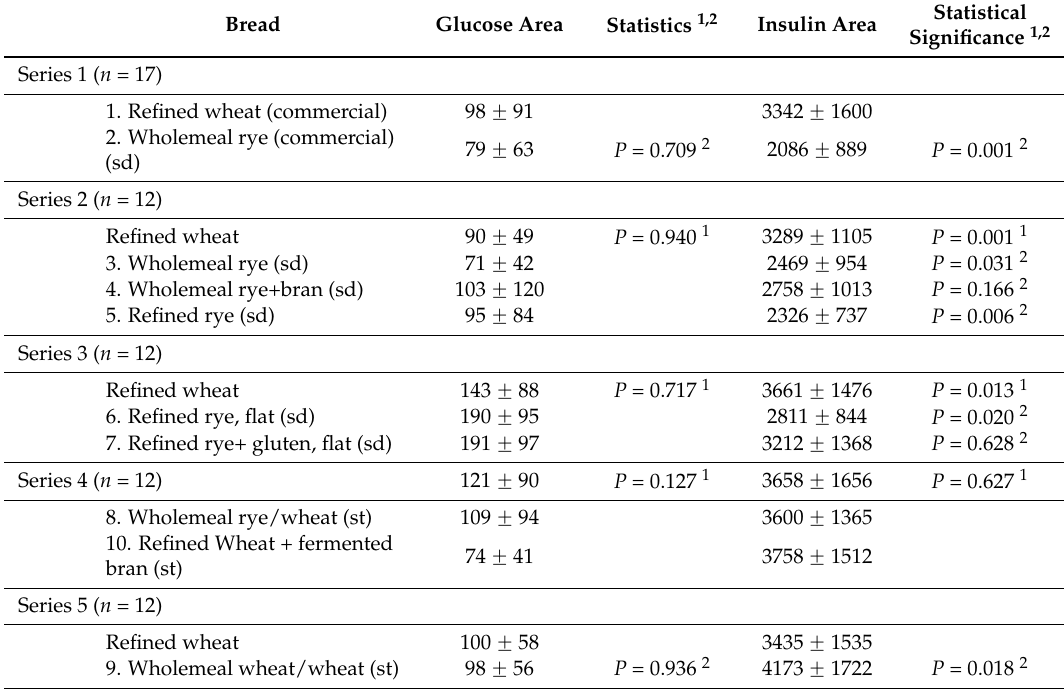
Table 3. The postprandial incremental blood glucose and insulin responses of the breads determined as areas under the curve (AUC) over 180 min. The values are shown as means with standard deviation. Statistical significance of differences within each series was assessed using the nonparametric Friedman´s test. In case a significant difference was observed, Wilcoxon´s test for pairwise comparisons was made to compare the other samples to refined wheat bread. In bread coding “sd” stands for sourdough and “st” for straight dough. Bread Glucose